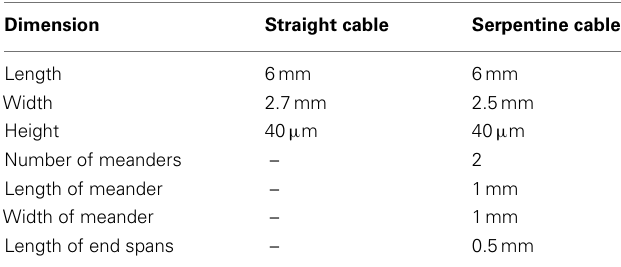
Table 1 | Dimensions of the straight and serpentine cables used in the analytical and numerical analysis.